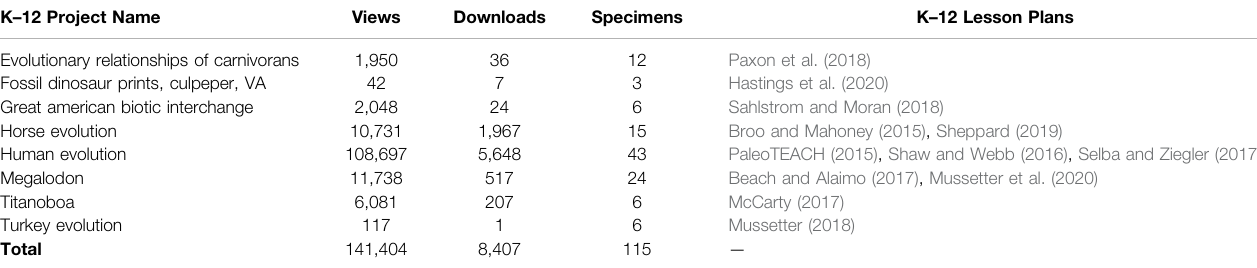
TABLE 1 | Breakdown of 3D paleontological data on MorphoSource used in K – 12 lesson plans through education and outreach projects at the